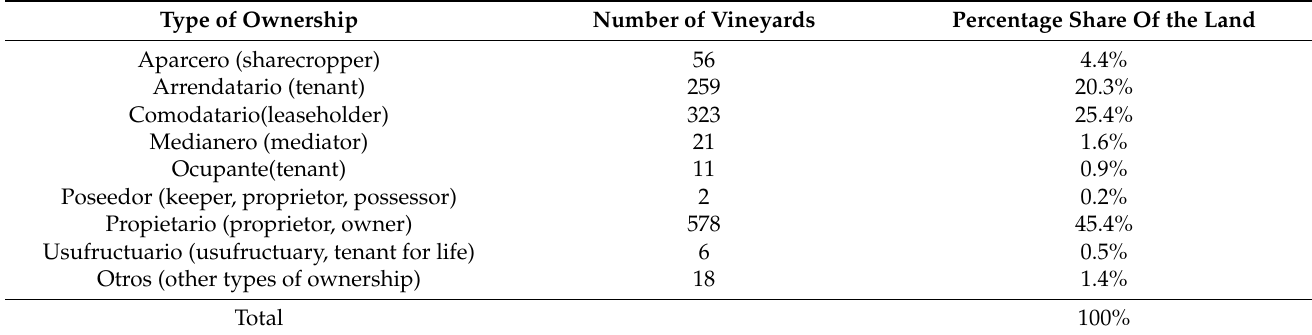
Table 3. Land ownership by typology.